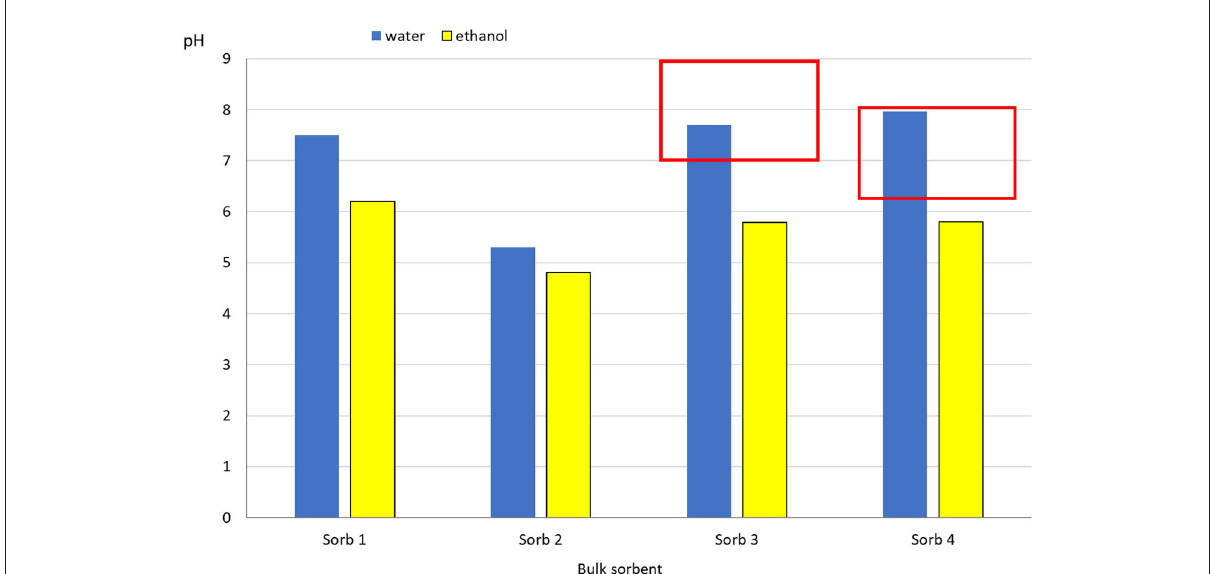
FIGURE6 Comparison of pH of the resultant mixture of loose sorbents with water and alcohol. Legend: the red border represents the interval of pH given by the